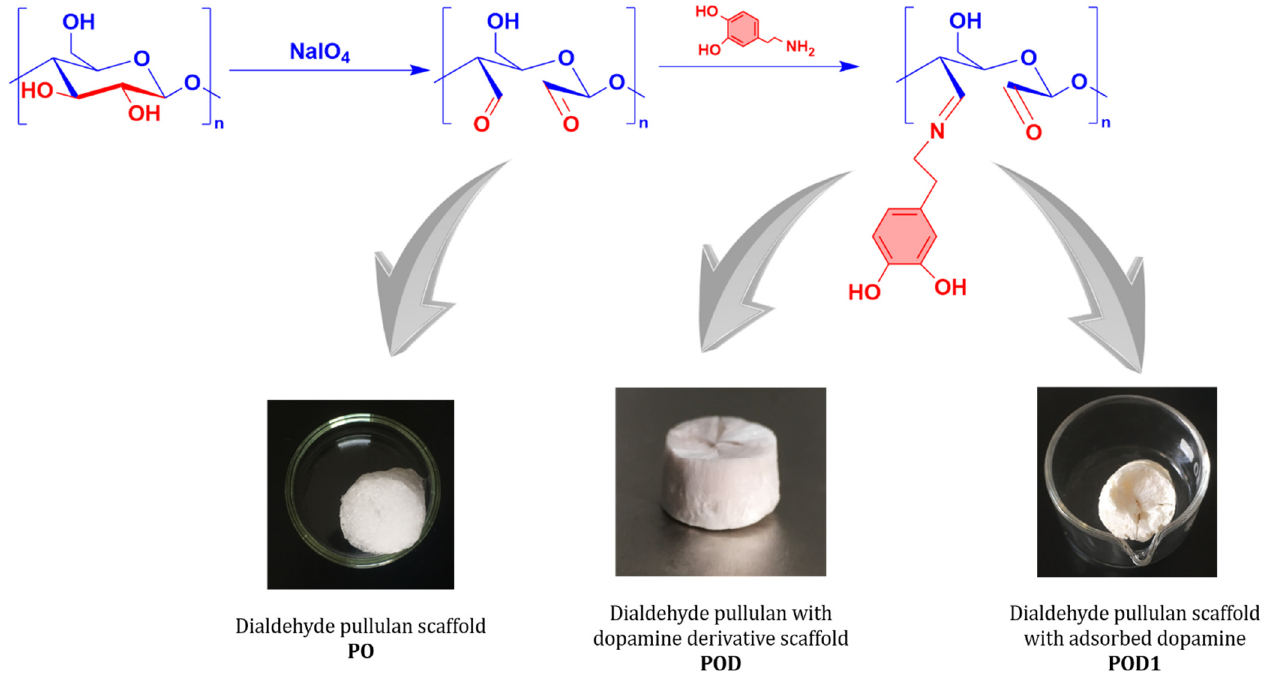
Figure 1. Schematic illustration of the conceptual reaction steps involved in the preparation of oxi- dized pullulan–dopamine cryogels and optical images of the resulting materials. oxidized pullulan–dopamine cryogels and optical images of the resulting